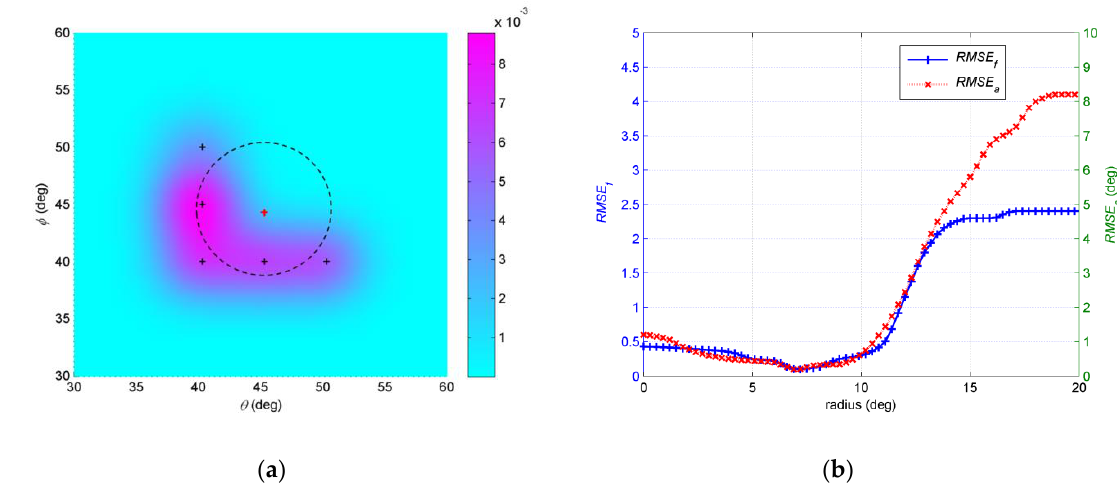
Figure 10. ( a ) Description of assumptive nominal angle (45°, 44°) and circles r equals 6.8°; ( b ) RMSE a and RMSE f estimated by different r with assumptive nominal angle (45°, 44°) .